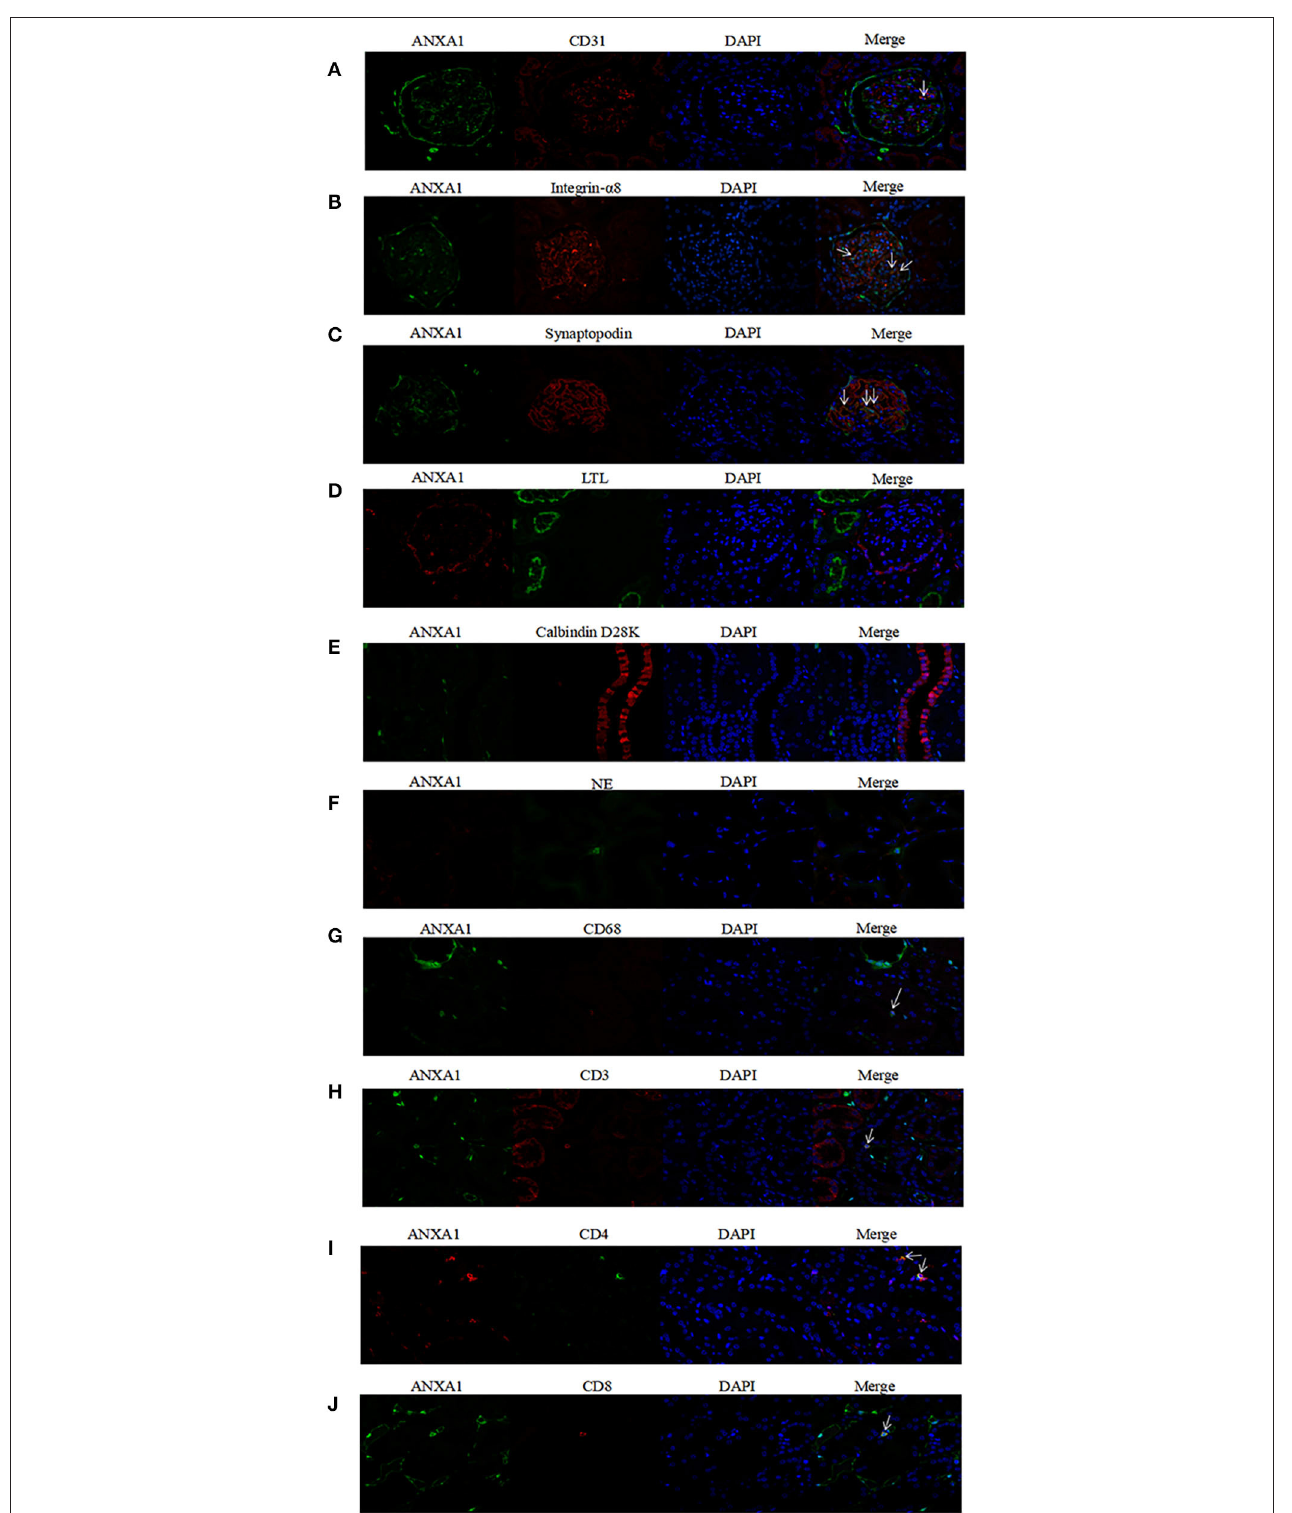
FIGURE 6 | Co-localization of ANXA1 and CD31 (A) , integrin- α 8 (B) , synaptopodin (C) , LTL (D) , Calbindin D28K (E) and NE (F) , CD68 (G) , CD3 (H) , CD4 (I) and CD8 (J) in renal specimens of healthy controls, respectively. AAV, anti-neutrophil cytoplasmic antibody (ANCA)-associated vasculitis; ANXA1, annexin A1; CD3, cluster of differentiation 3; CD4, cluster of differentiation 4; CD8, cluster of differentiation 8; CD31, cluster of differentiation 31; CD68, cluster of differentiation 68; LTL, lotus tetragonolobus lectin; NE, neutrophil elastase.